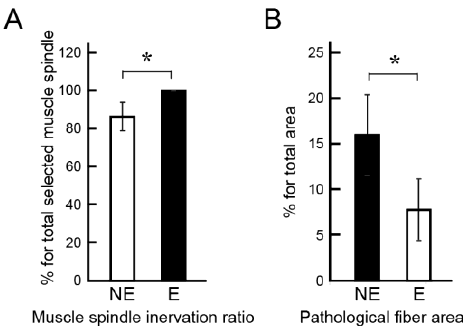
Figure 5. Comparison of the innervation of muscle spindle and pathological fiber area. ( A ) Muscle spindle innervation ratio determined by 23 spindles. The E group showed 100% innervation, which is significantly higher than NE group (87%); ( B ) Existence of pathological muscle fiber area account for a percentage of total area of cross-section. The E group showed significantly lower existence of pathological fibers. * p < 0.05.